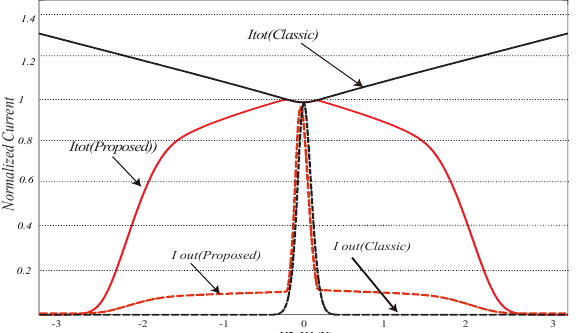
Figure 10. Comparison of the currents in the proposed bump circuit and the classic bump circuit. The black curves are the normalized currents in the classic bump circuit and the red curves the currents in the proposed circuit. The dashed curves are the output currents.